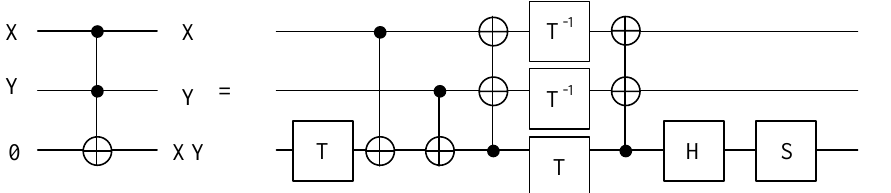
Figure 3. Decomposition of Toffoli gate as temporary logic AND with T-count = 4 and T-depth = 2 [10].